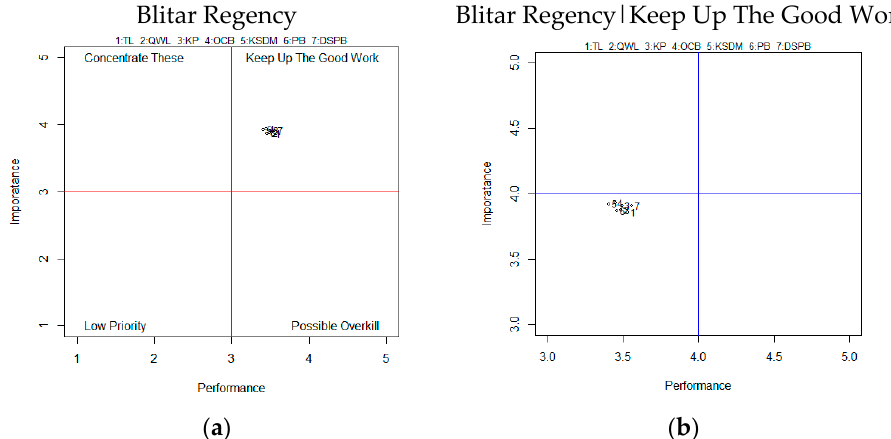
Figure 9. ( a ) IPA Cartesian Diagram of Blitar Regency. ( b ) IPA Cartesian Diagram of Keep up the Good Work Quadrant of Blitar Regency.